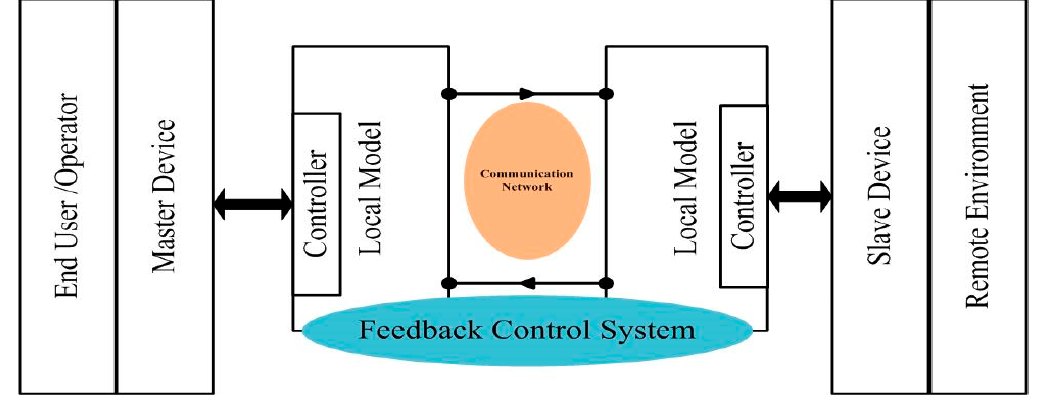
Figure 3. General view of the end-to-end system structure for the bilateral teleoperation systems.